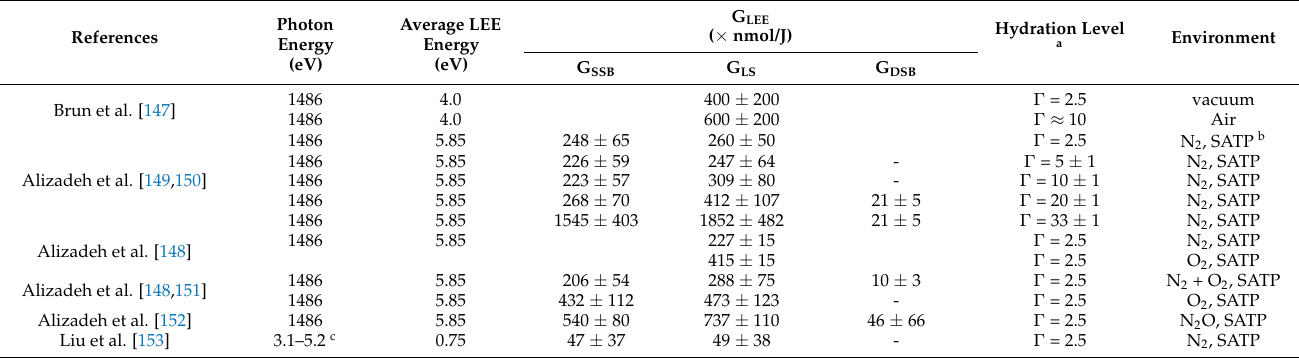
Table 1. Comparison of G-values for SSBs (G SSB ), DSBs (G DSB ) and loss of supercoil (total damage, G LS ) induced by UV and X-ray photoelectrons emanating from a metal substrate covered with 5 MLs of plasmid